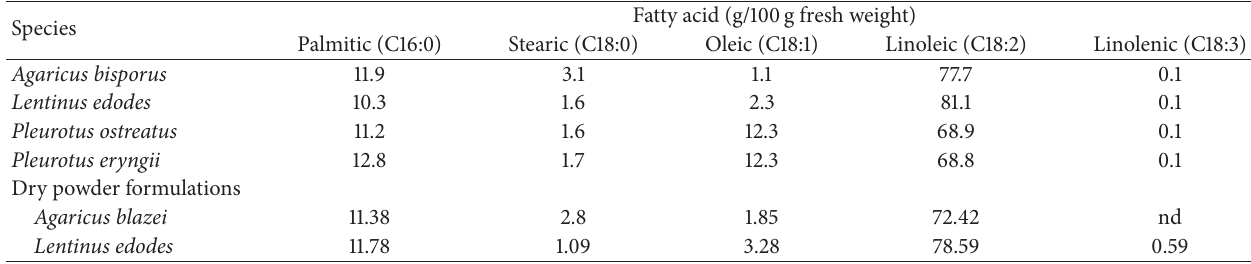
Table 3: Fatty acids content of some edible